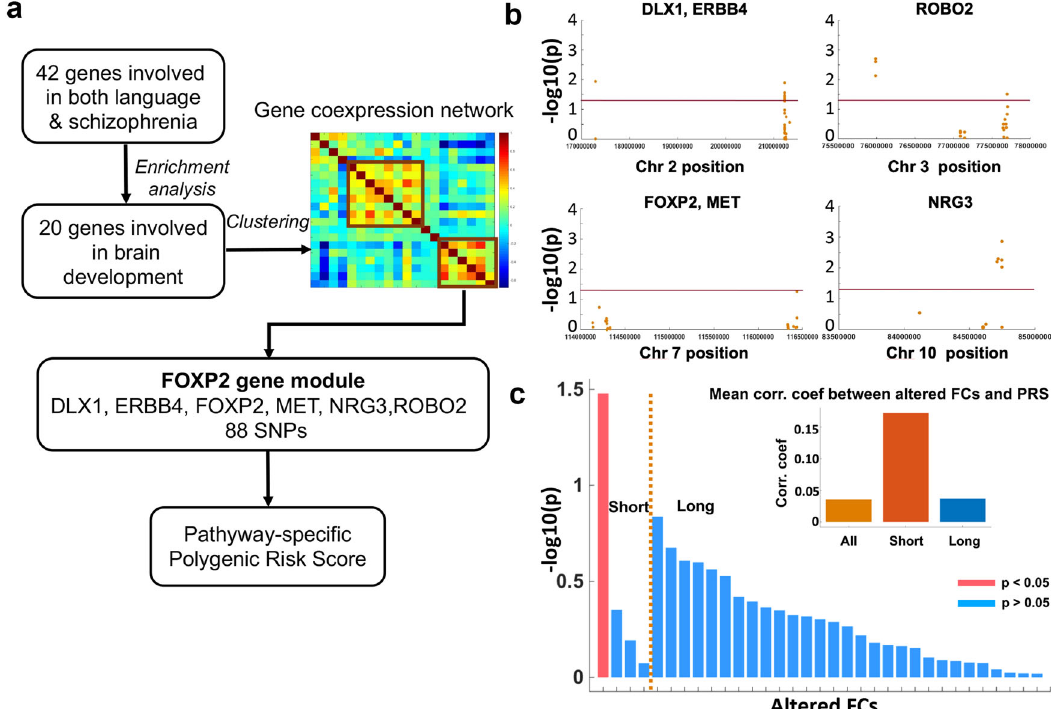
Fig. 3 Genetic association analysis between altered functional connectivities (FCs) identi fi ed in FES patients and language-related genes. a Work fl ow to choose candidate genes in genetic association study. We identi fi ed one gene cluster (with 6 genes) containing FOXP2, which is related to neurodevelopment, language, and schizophrenia. b Association analysis between the 88 SNPs in the 6 genes in the FOXP2 cluster and schizophrenia. c Correlation coef fi cients between the pathway-speci fi c polygenic risk scores (PRS) obtained from the above 6 genes and each of the altered FCs identi fi ed in both the short-duration patient group and the long-duration patient group. The bars represented the log P values of the correlation between the PRS and 4 altered FCs identi fi ed in short-duration group and the 29 FCs identi fi ed in the long-duration group (the red bar indicate p < 0.05). The upper right part of this fi gure showed the mean value of the correlation coef fi cients (between altered FCs and PRS) in different patients groups (orange for all FES patients, red for short-duration FES group, and blue for long-duration FES